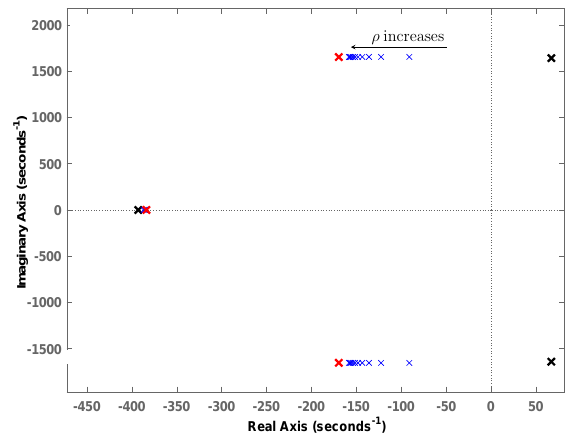
Figure 9. Comparison between original and proposed output impedances of the LRC, highlighting the capability of the proposed controller in removing the interaction.